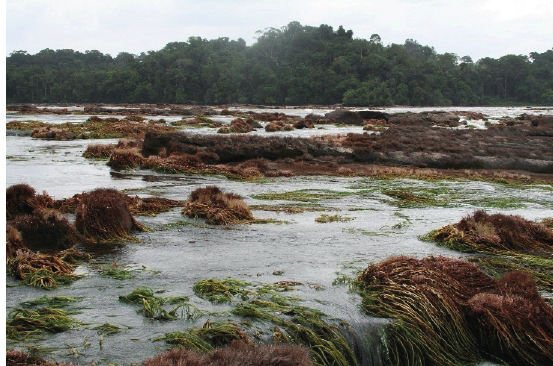
Figure 1. Carrao River, Orinoco River Basin, Venezuela with Podostemaceae